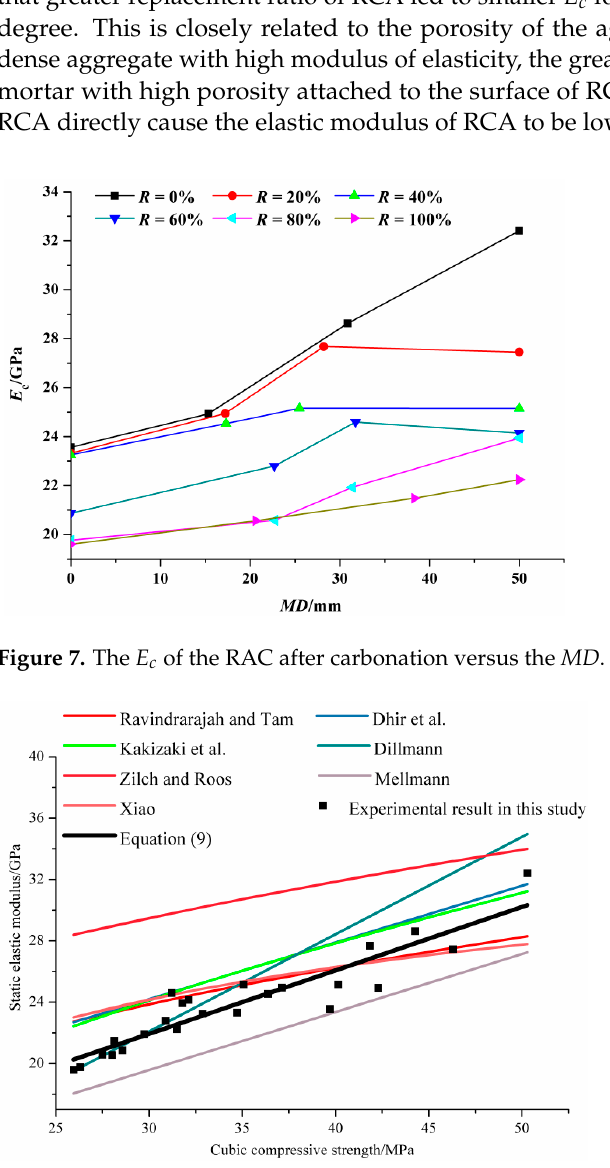
Table 6. Equations that correlate elastic modulus with cubic compressive strength of RAC.